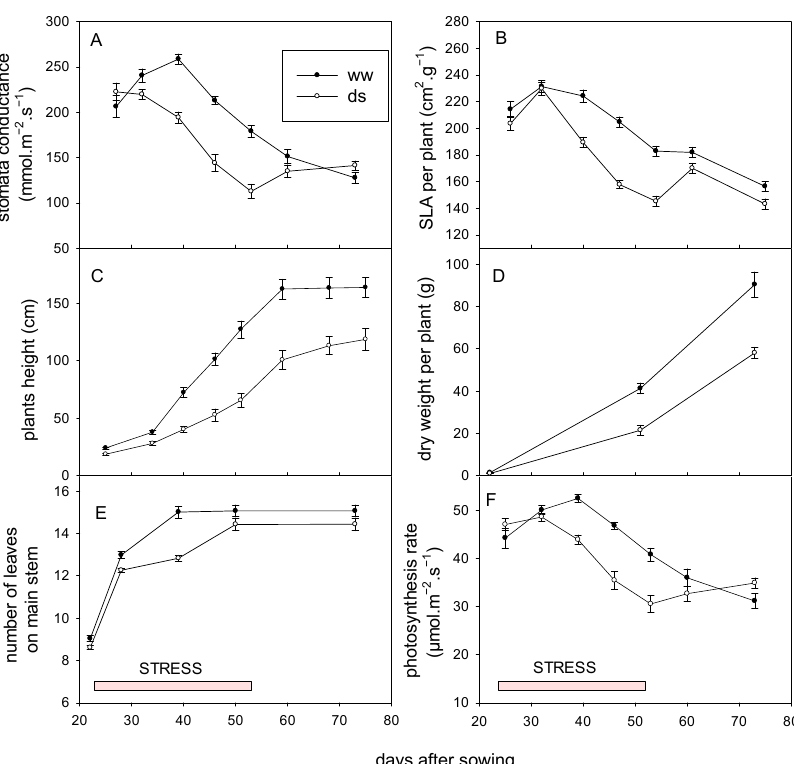
Figure 3. Evolution of stomata conductance ( A ), specific leaf area (SLA) per plant ( B ), plants height ( C ), dry weight ( D ), number of leaves ( E ) and photosynthesis rate ( F ) of sorghum varieties under well-watered and drought stress conditions. ww: well-watered; ds: drought stress.